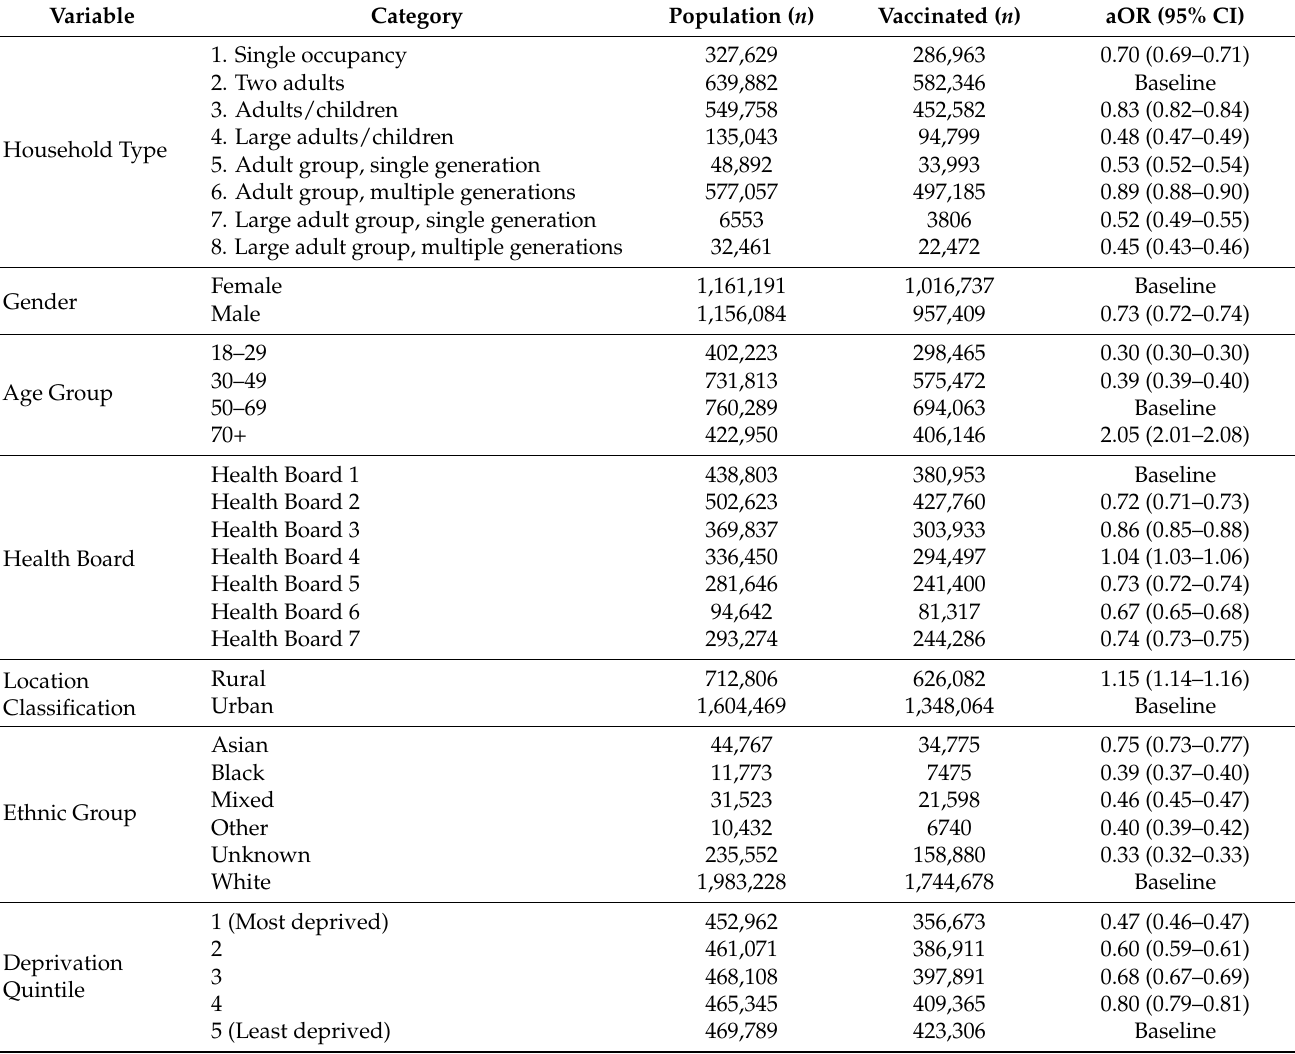
Table 3. Multivariable regression model estimates for vaccinations with two doses of COVID-19 vaccine (any type) Wales a,b